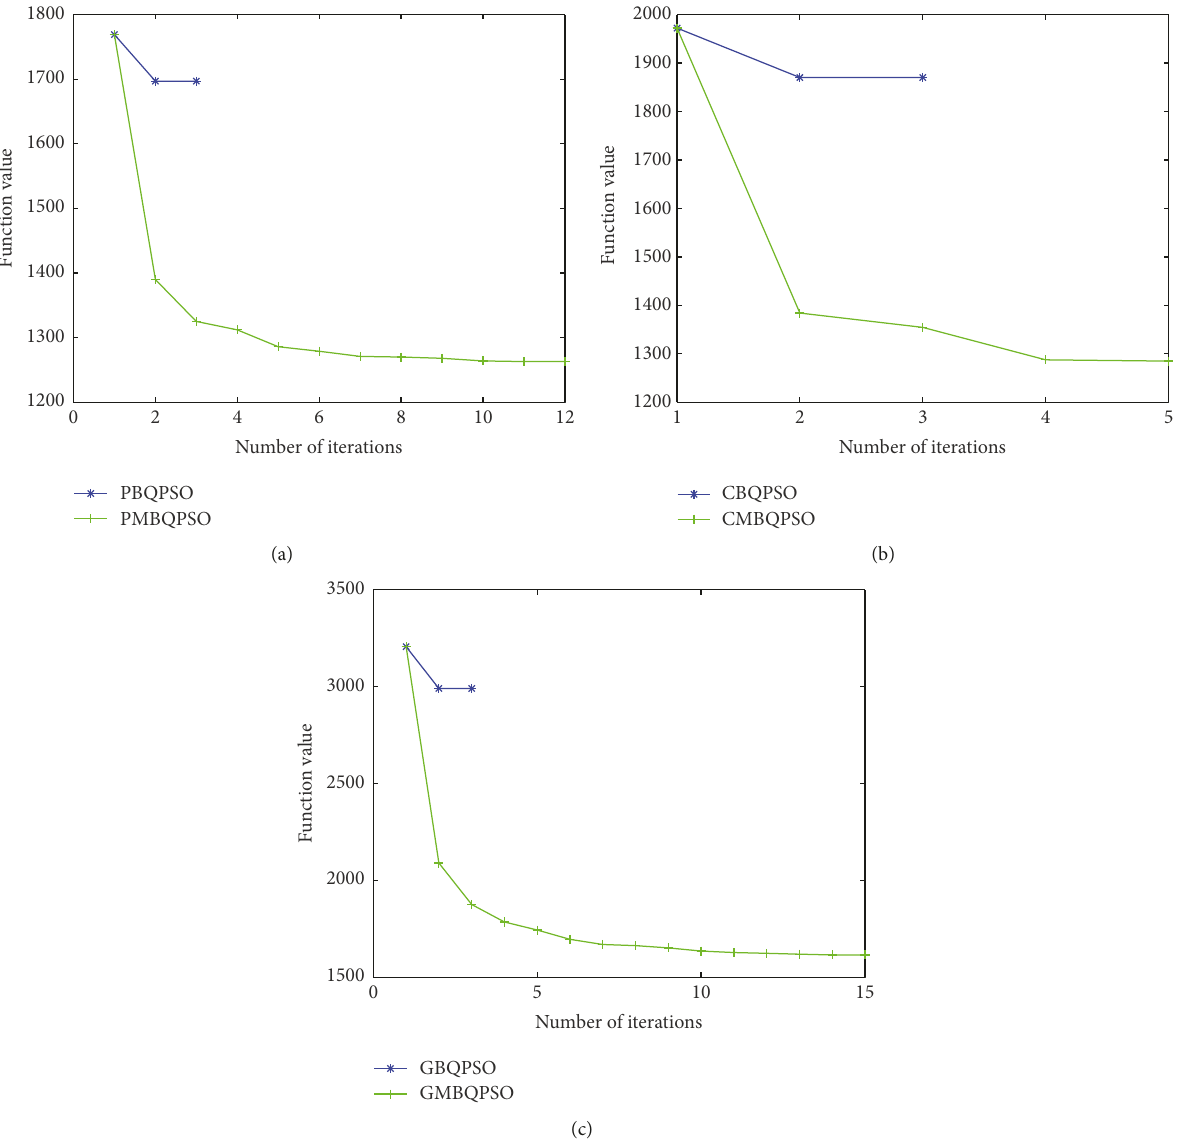
Figure 6: The iterations change curves with the space resolution enhancement ratio 3 × 3 : (a) 𝑓 point method, (b) 𝑓 chain method, and (c) 𝑓 gap